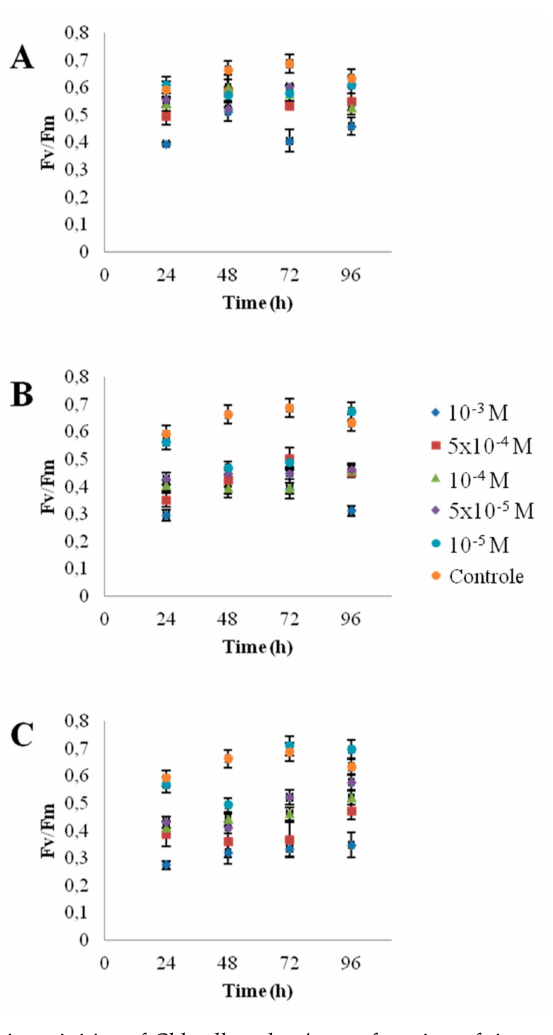
Figure 6. Photosynthetic activities of Chlorella vulgaris as a function of time after contact with ZnO, CdS-1 and CdS-2 nanoparticles in Seine river water: ( A ) ZnO, ( B ) CdS-1, ( C ) CdS-2.